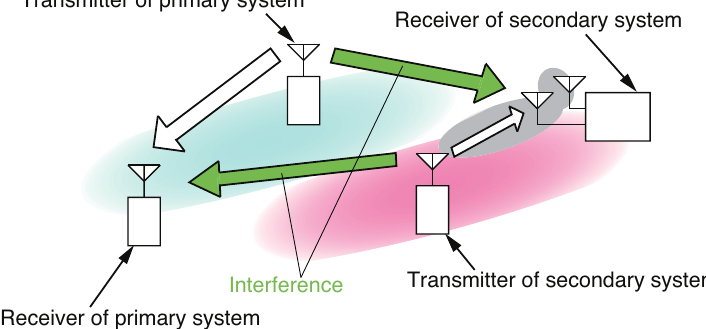
Figure 1. System model.